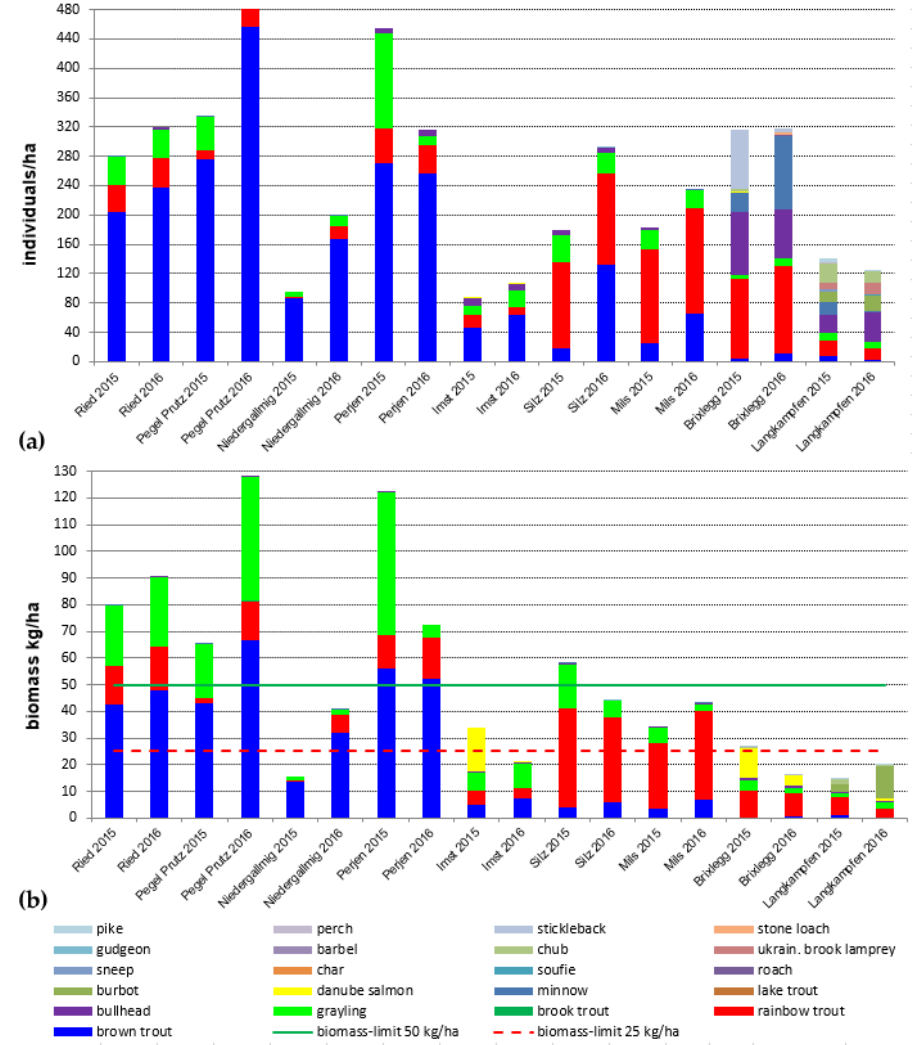
Figure 5. Comparison of ( a ) fish abundance and ( b ) biomass for the pre- and post-monitoring. In the “non-glaciated central Alps” fish bioregion (expect sites above 1000 m a.s.l. and rivers with strong and 50 kg / ha corresponds to poor ecological status and locations with biomass values below 25 kg / ha automatically classified as bad ecological